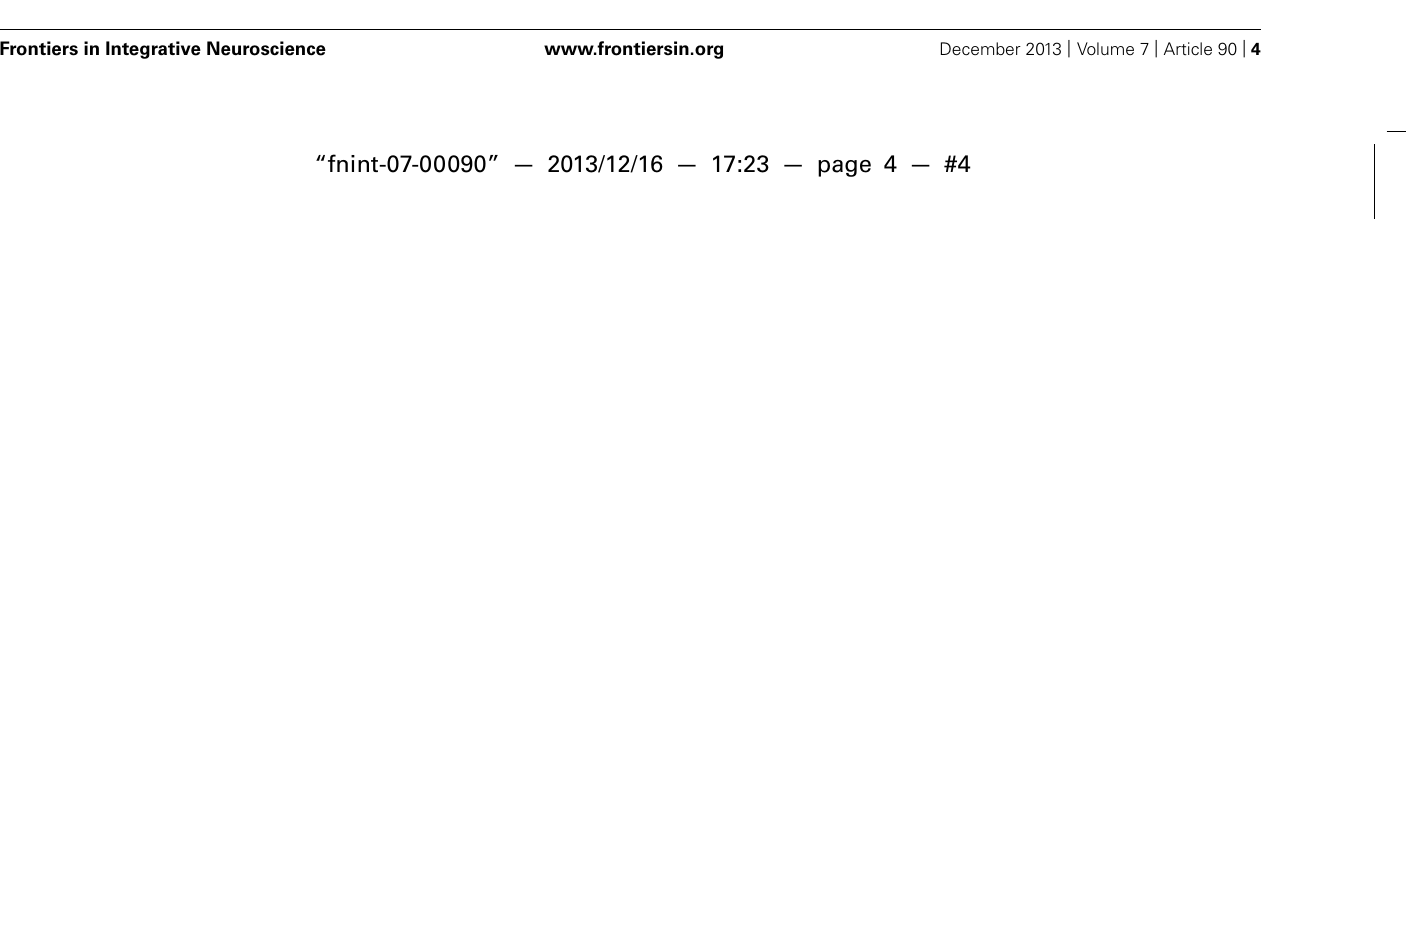
FIGURE 2 |Angular displacement (returned to the computer by the axis control card) and velocity (computed offline) of the chair in each tested combination of acceleration and decele- ration. Rotation onset occurred 500 ms after the onset of the